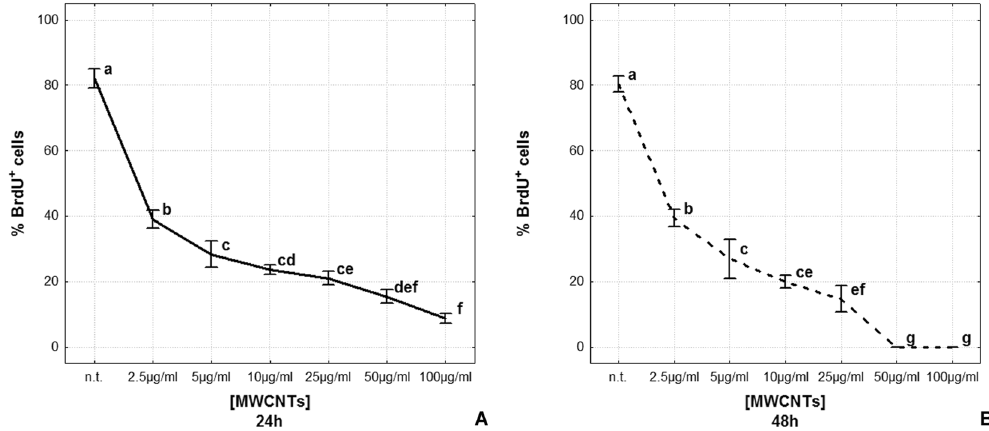
Figure 3. Cell proliferation rate after MWCNT in vitro treatment ( A , B ). The graphs show the percentage of BrdU + cells after 24 h ( A ) and 48 h MWCNT treatment ( B ). Statistical differences were calculated by Factorial ANOVA followed by Tukey’s post-hoc test; vertical bars denote standard deviation, different letters indicate statistically significant differences (p <